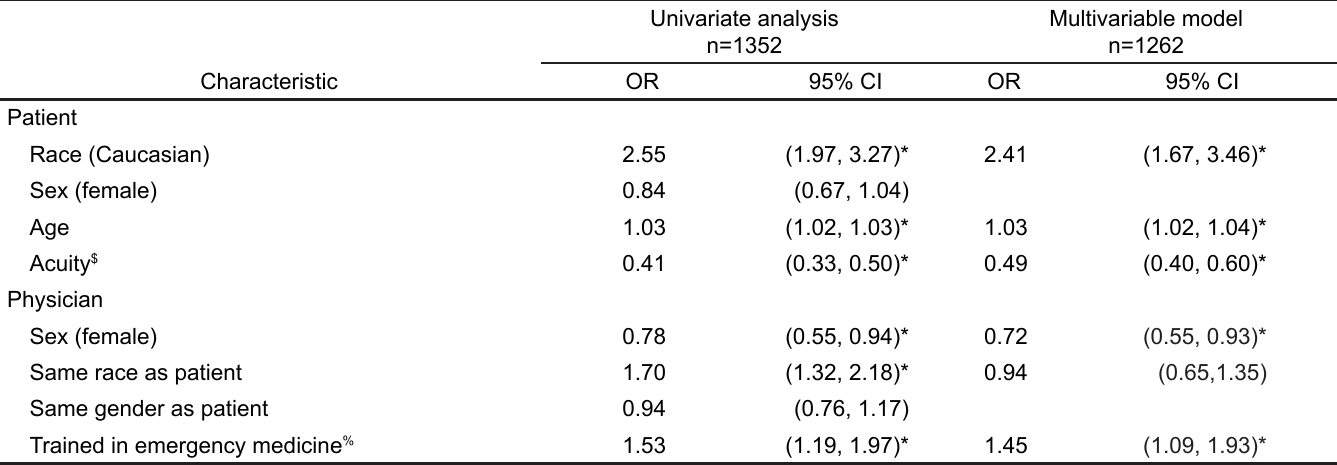
Table 6. Univariate and multiple logistic regression analysis of opiate administration to patients with back pain who received analgesia.